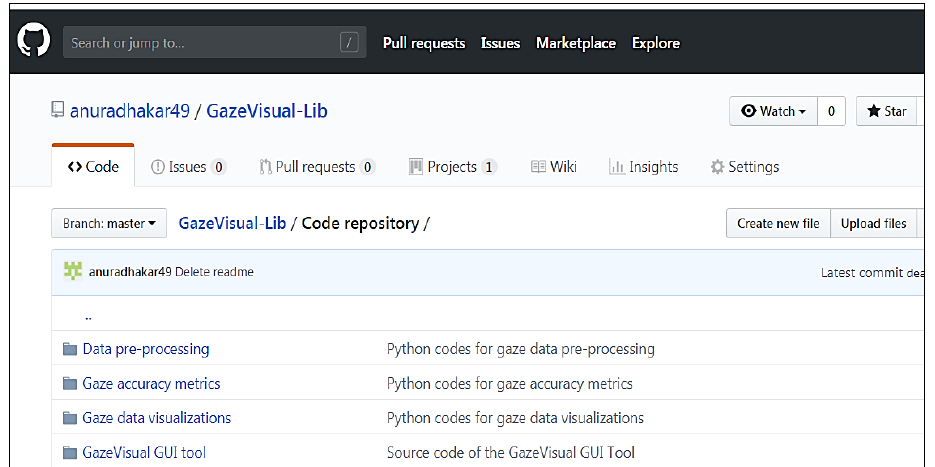
Figure 2. View of the GazeVisual-Lib code repository on GitHub.